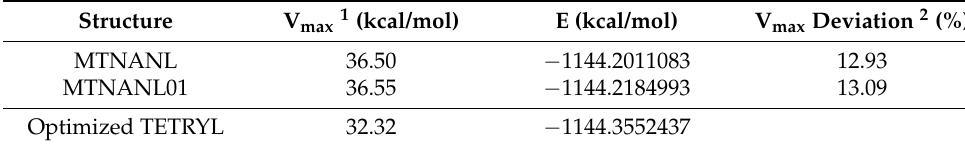
Table 5. Total energies, V max deviations and V max values in critical points above the centers of nitroaromatic rings calculated for selected crystal structures containing TNT molecule.